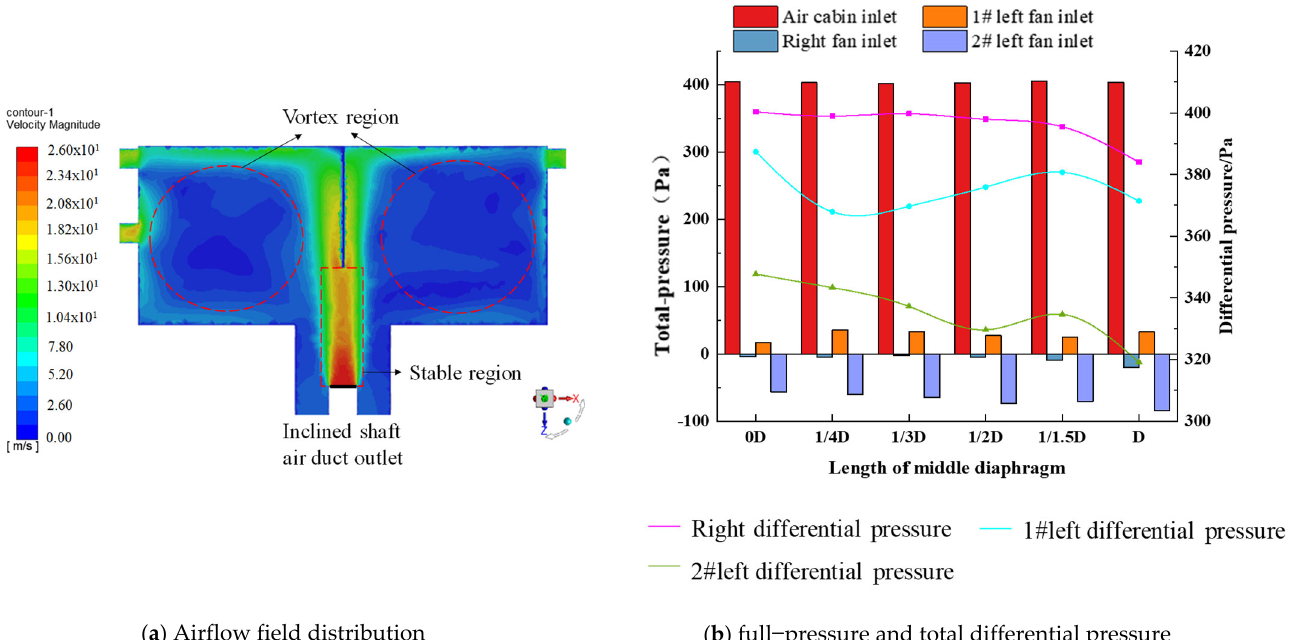
Figure 13. Airflow field distribution and differential pressure in different lengths of the middle diaphragm.